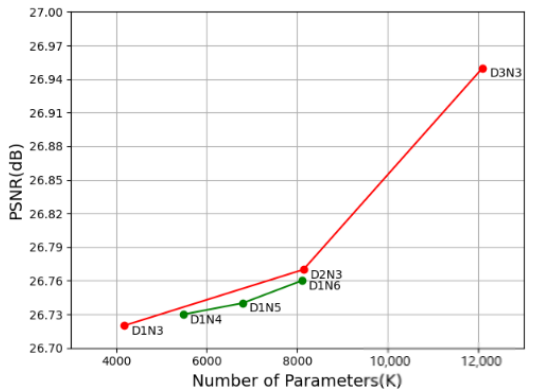
Figure 7. PSNR (dB) vs. Parameters on Set14 (×4) training 100 epochs on dataset T91 [8]. The red line indicates the rising tendency of PSNR value by magnifying D from 1 to 3 with a fixed N, while the green line denotes the growth trend of PSNR value by increasing N from 4 to 6 with a fixed D.